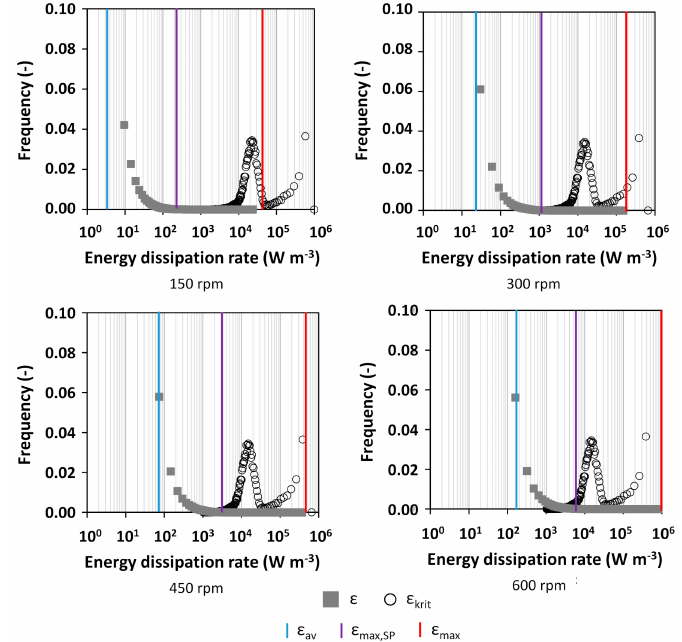
Figure 8. Critical energy dissipation rate distributions (black circles) in the TIS compared to the energy dissipation rate distribution in the reactor system (grey squares). The averaged energy dissipation rates from CFD simulations are indicated in blue, their maxima in red, maximum energy dissipation rates calculated from slice plots are indicated in